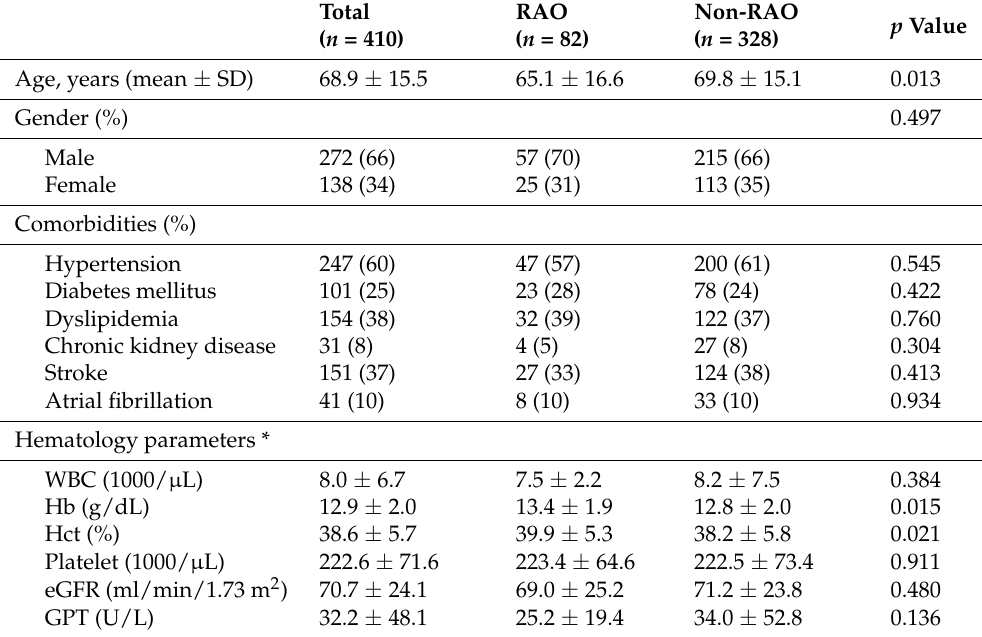
Figure 1. Flow chart of the patient selection process. RAO, retinal artery occlusion; ICD, interna- tional classification of diseases. * Note: the comorbidities included hypertension, diabetes mellitus, dyslipidemia, chronic kidney disease, stroke, and atrial fibrillation. Table 1. a. Baseline characteristics of RAO patients, n = 410. b . Fundus change of RAO patients.